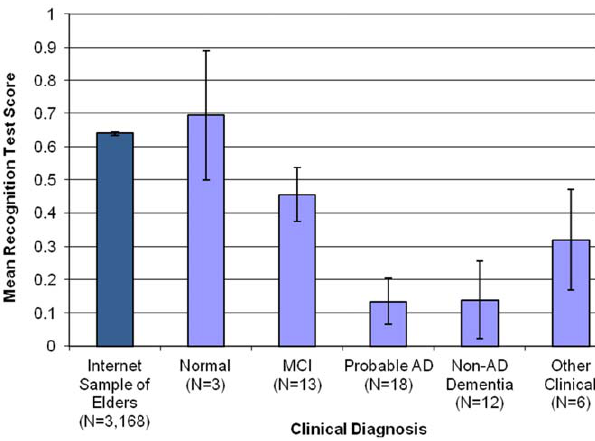
Figure 3. Recognition memory test scores (means ± standard errors) for the Clinical Validation Sample, as a function of subsequently-assigned clinical diagnosis. Performance of $ 50 year-old participants from the anonymous Internet sample shown for comparison.